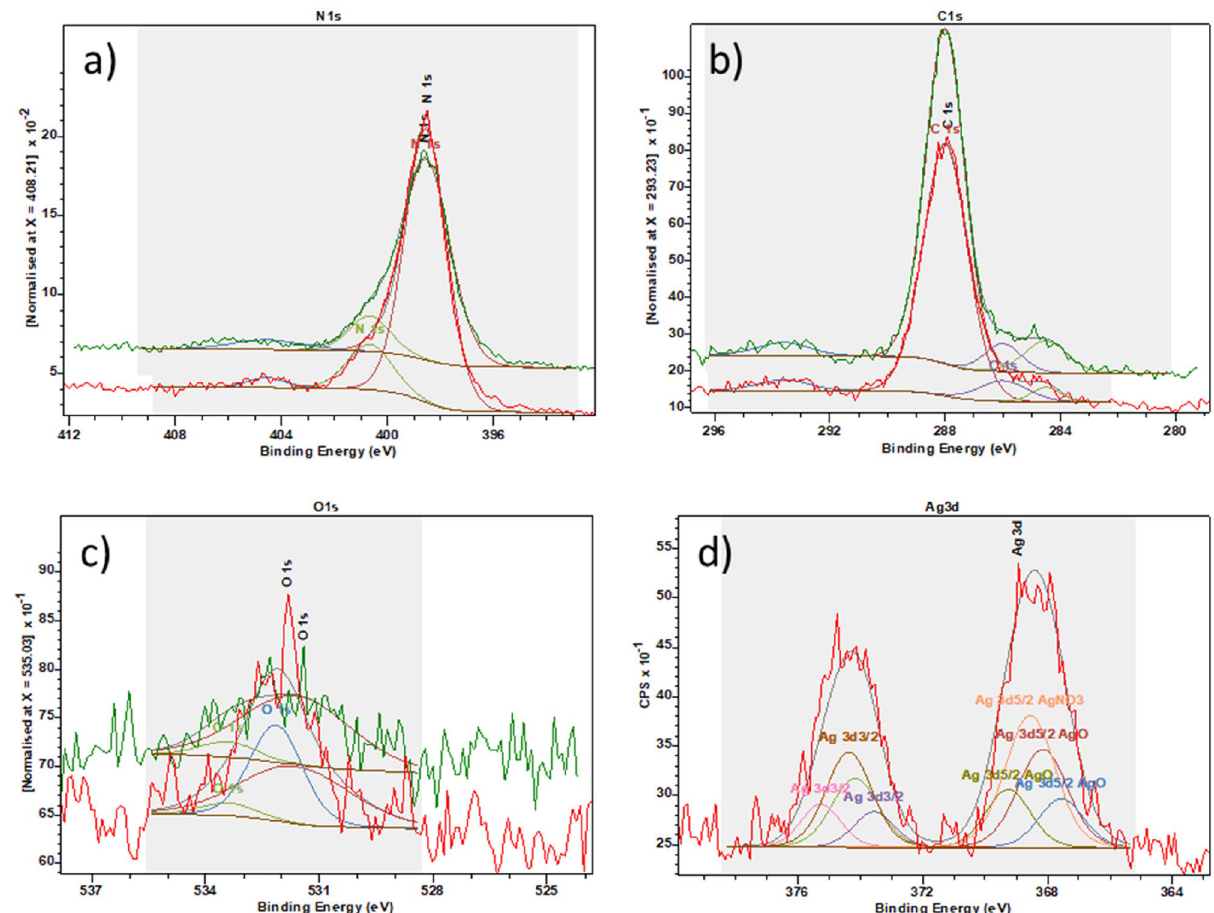
Figure 12. High resolution XPS spectra of N1s ( a ), C1s ( b ), O1s ( c ) and Ag3d ( d ) registered for the samples MM-g-CN (green) and MM-g-CN-2.5% Ag